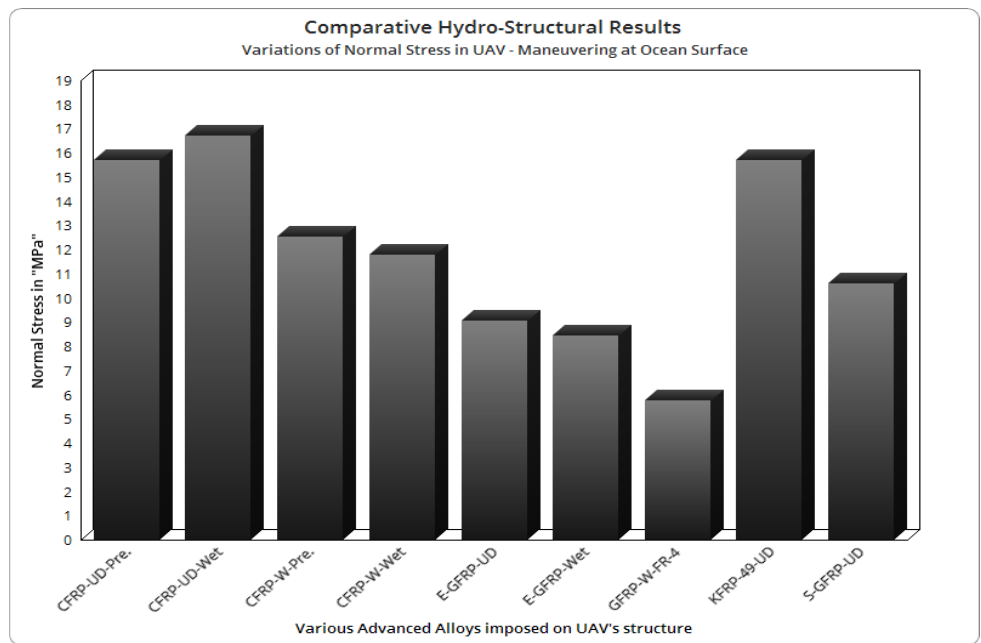
Figure 30. Comparative normal stress variations for various composites.